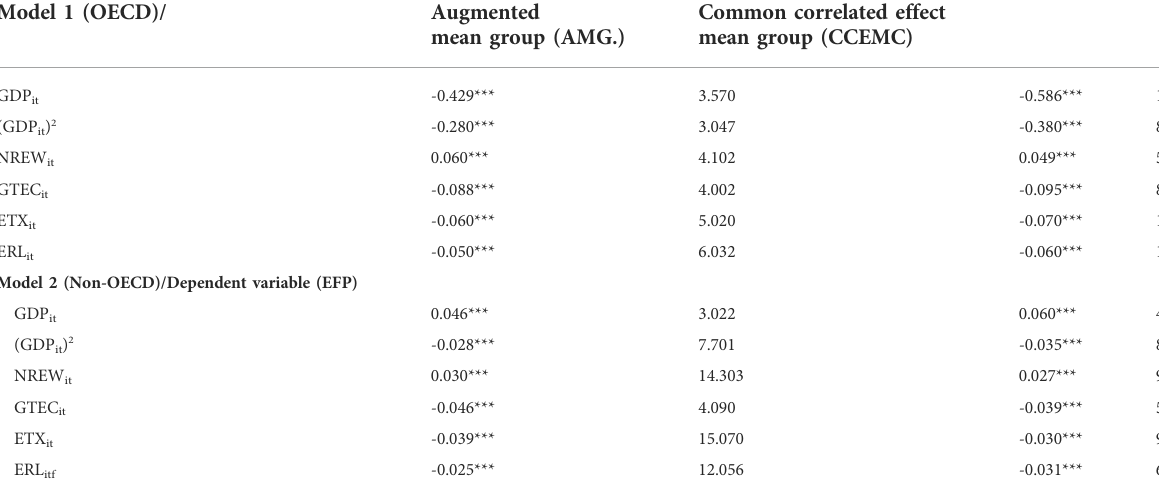
TABLE 7 Long run AMG and CCEMG for robustness check.